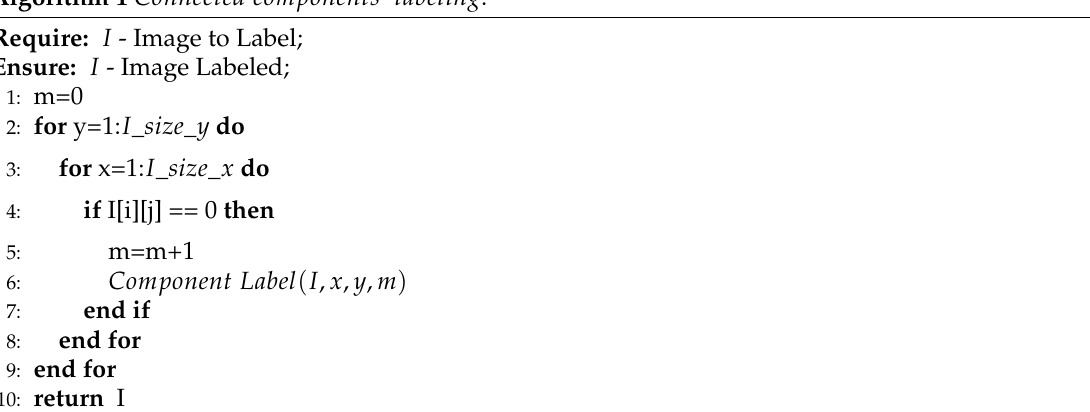
Algorithm 1 Connected components (cid:48) labeling